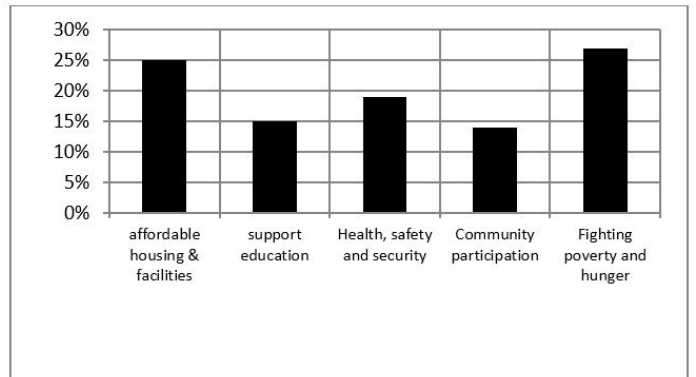
Figure 2. Sustainable Housing Social Priorities in Sudan